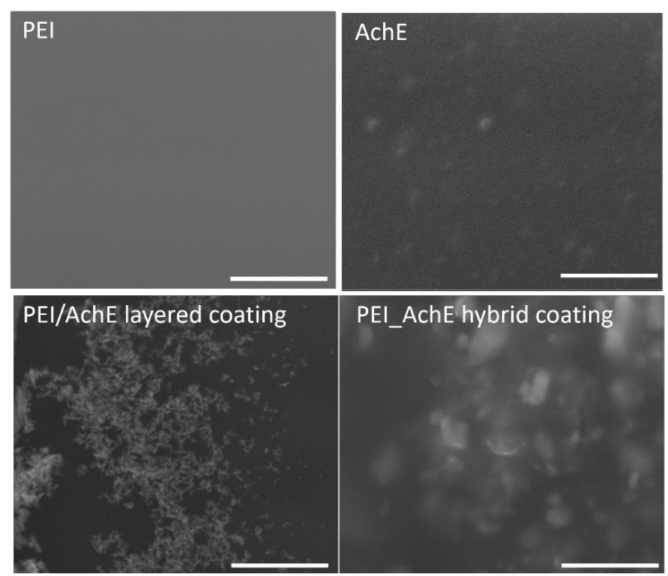
Figure 4. SEM images (with 20,000 magnification) of the samples obtained by MAPLE. (Scale bars: four µ m).